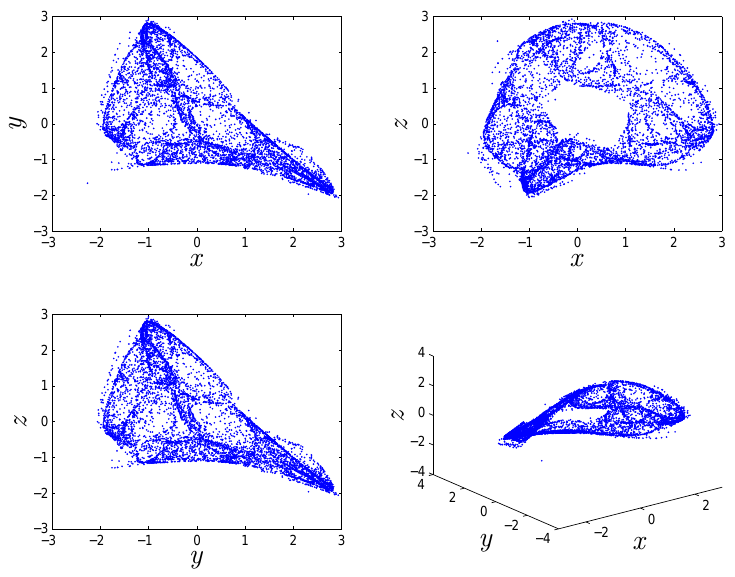
Figure 1. Different phase space projection of the hidden chaotic attractor of the FoDS given in (7), when γ =